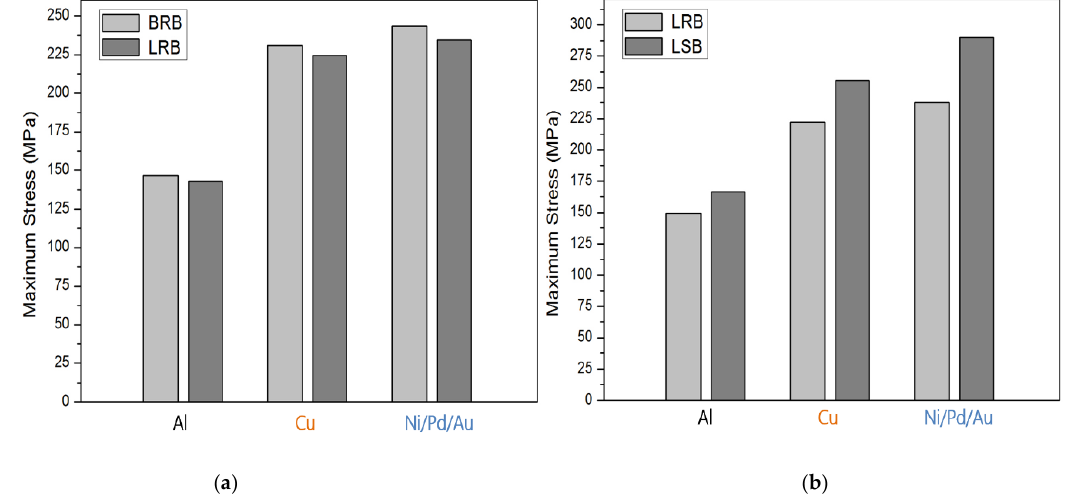
Figure 11. Comparison of the maximum stress of 5-μm thick specimens: ( a ) BRB and LRB; ( b ) LRB and LSB.